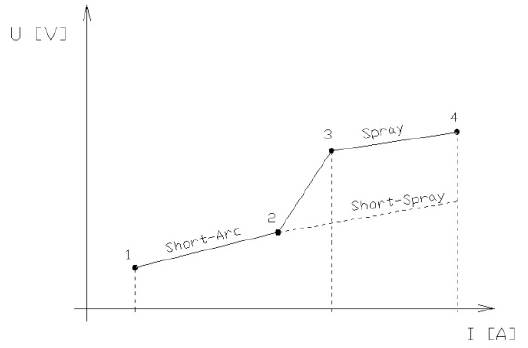
Fig. 14. Short-spray process in synergic diagram Monitor record on fig. 15 shows rapid shorting (even more than 600 per second) of small droplets.